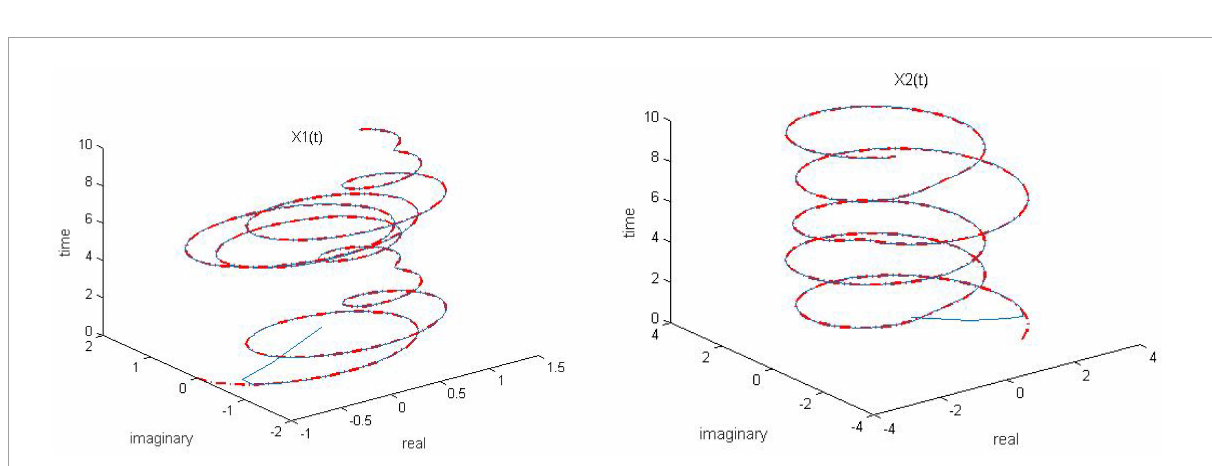
FIGURE8 Dynamic complex matrix equation (DCME) (1) solved by robust zeroing neural network (RZNN) model (11) with k = 2 in n(t) = 0.5 polluted